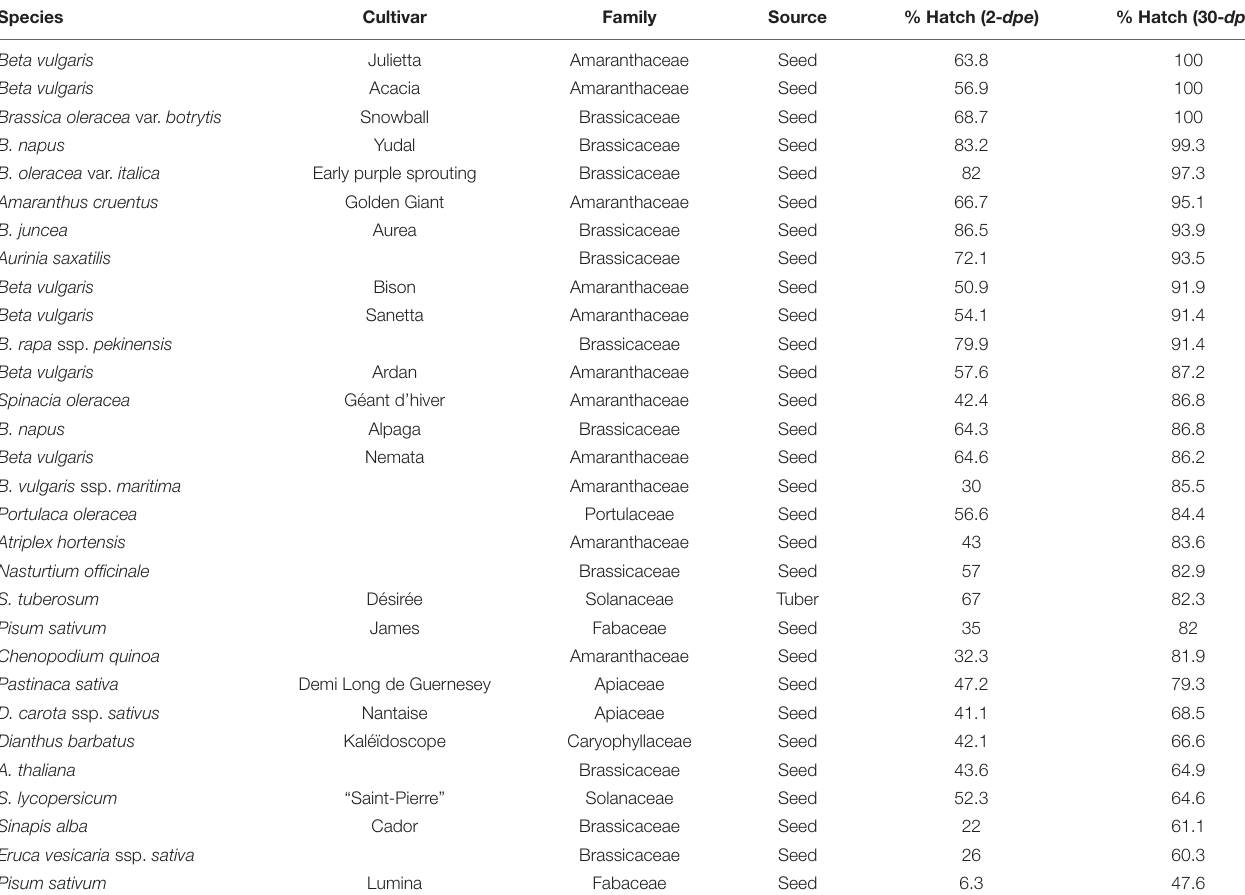
TABLE 1C | Plant species and/or cultivars screened for the ability of their root exudates to induce hatching of Heterodera schachtii in vitro. Species Cultivar Family Source % Hatch (2- dpe